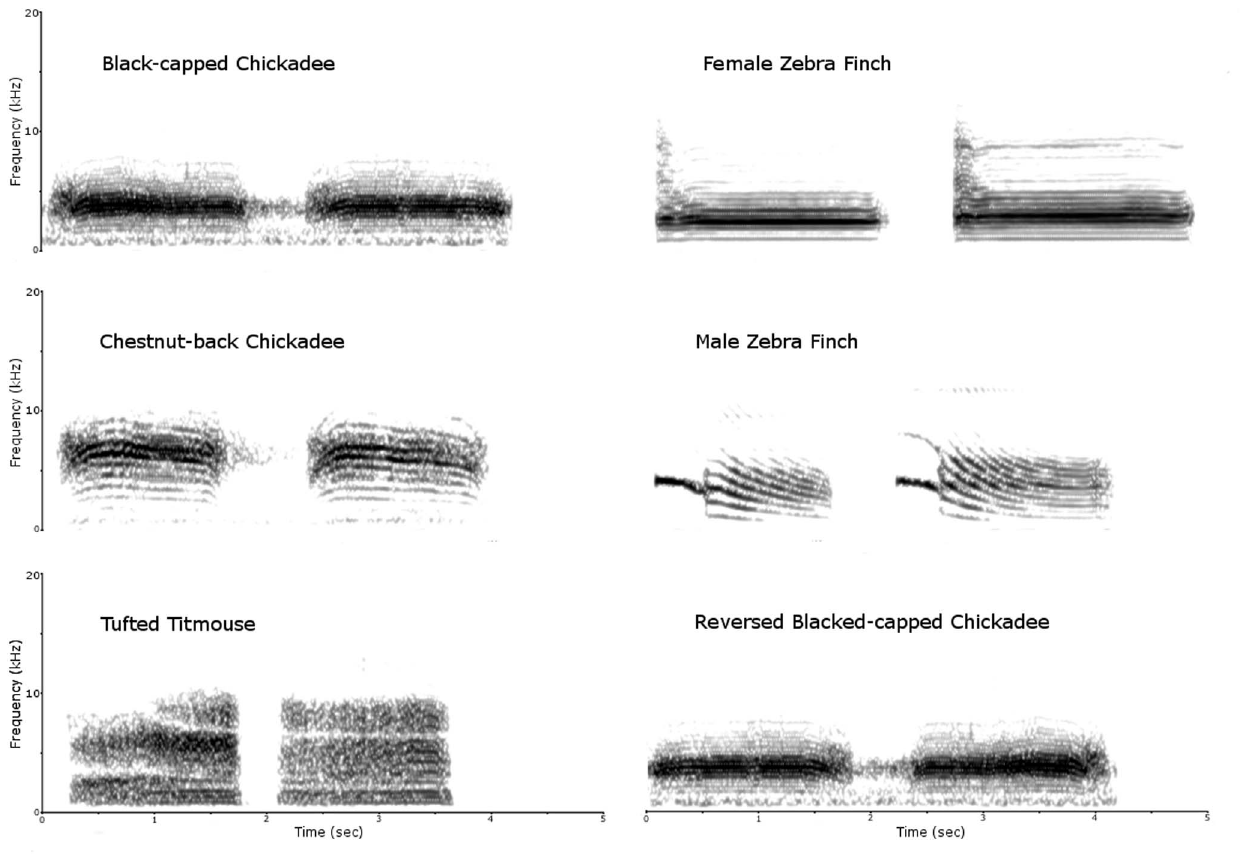
Figure 1. Example call spectrograms. Stimulus sets for (A) black-capped chickadee ‘ dee ’ note calls; (B) reversed black-capped chickadee ‘ dee ’ note calls; (C) female zebra finch distance calls; D) chestnut-backed chickadee ‘ dee ’ note calls; (E) tufted titmouse calls; and (F) male zebra finch distance calls (fast Fourier transform window =256 points).